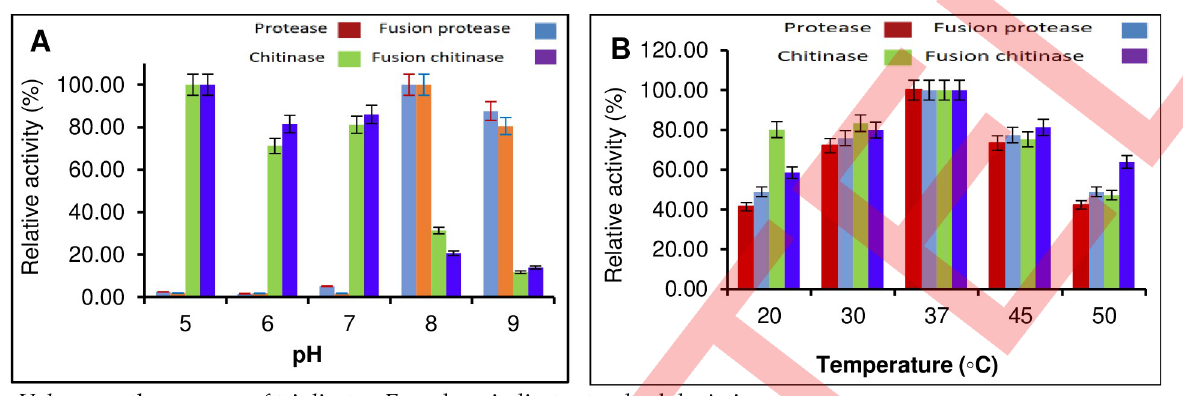
Fig 5. Activities of the purified proteins at pH 5–9 Values are the average of five replicates and significant at P < 0.05 (A); Activities of the purified proteins at 20–50˚C. Values are the average of five replicates and significant at P < 0.05 (B).